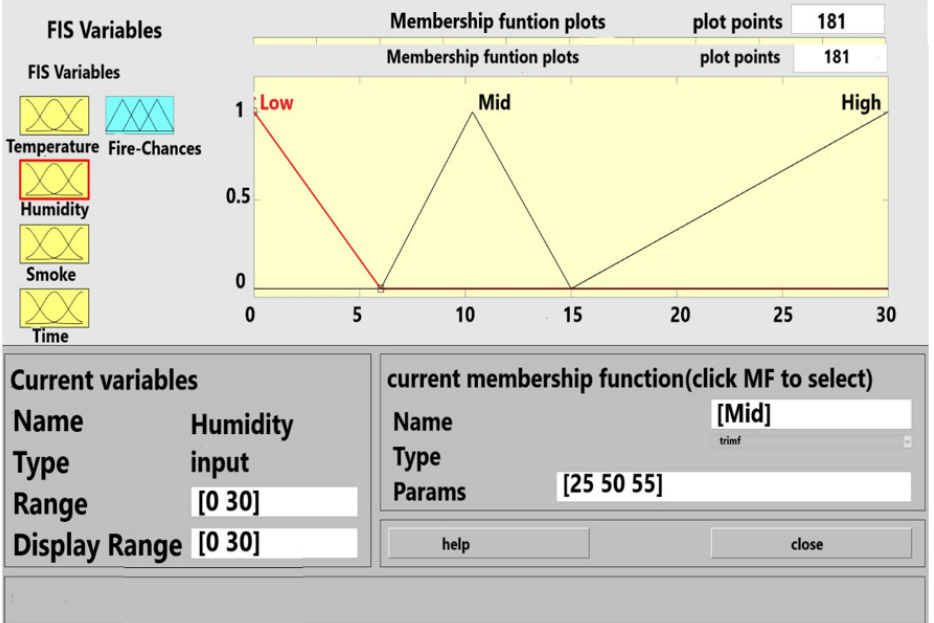
Figure 19. Membership Function for temperature sensor (Temp-S). Membership Function for (Humidity-S) humidity sensor: In Figure 20 LOW, MID, High are the three linguistic fuzzy variables used for representation of Humidity-S. The y -axis value is given in a range between 0 and 1, respectively, for x -axis value is represented by a range from 0 to 30, where the linguistic fuzzy variable low resides between 0% to 6% and medium variable resides in between the range of 6% to 15%. The linguistic fuzzy variable High is represented by the range from 15% to 30%, these values are based on the Universe of disclosure calculated for the Humidity sensor (Humidity-S) described in Table 4.